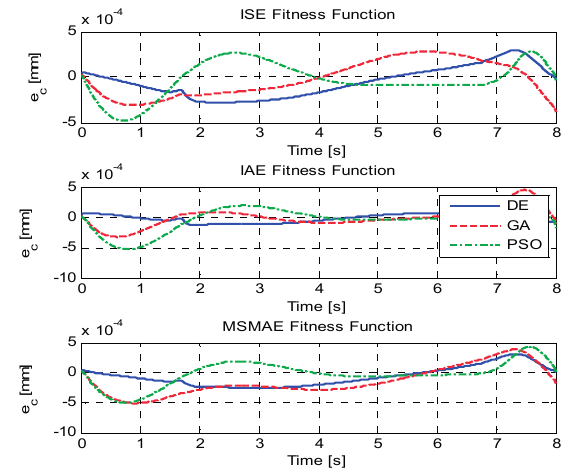
Figure 5. Contour performance for linear contour.